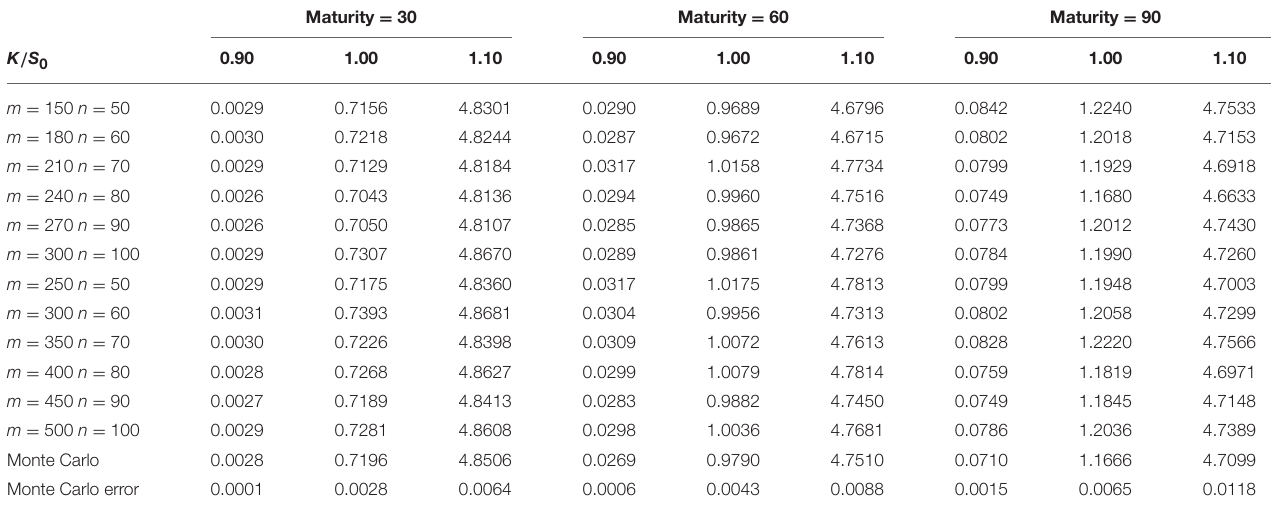
TABLE 4 | European put options in the NTS-GARCH framework.